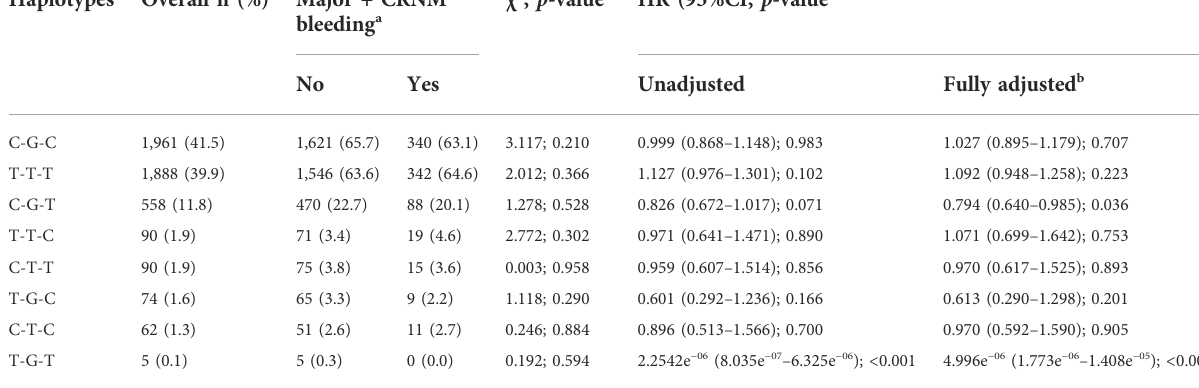
TABLE 5 Cox proportional hazards regression with time-varying analysis assessing the independent association of 1236C > T (rs1128503), 2677G > T/A (rs2032582), and 3435C > T (rs1045642) ABCB1 haplotypes with bleeding from DOACs.